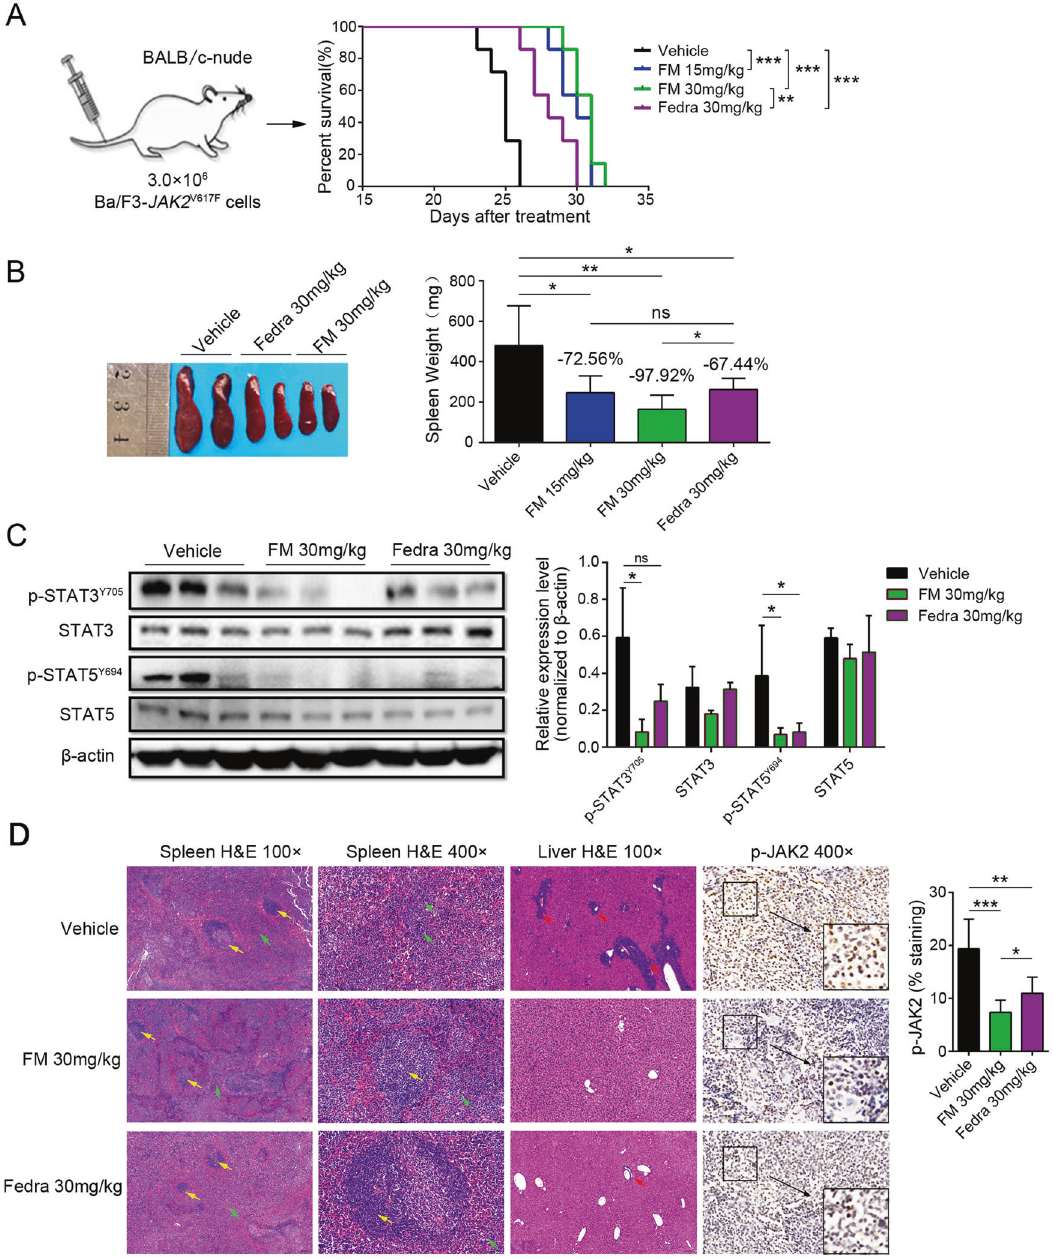
Fig. 3 Effective inhibition of JAK2 V617F -induced MPN mouse model in vivo by FM. BALB/c-nude mice received intravenous inoculation of 3.0 × 10 6 Ba/F3- JAK2 V617F -GFP cells and were administered with the vehicle, FM 15 and 30 mg/kg, and fedratinib 30 mg/kg bid. p.o. after 3 days, and the mice were executed after 22 days of treatment. A Kaplan – Meier analysis of survival between the vehicle-, FM- and fedratinib-treated groups was performed using the log-rank test ( n = 7). B Spleens were acquired and analyzed ( n = 6). C Western blot analysis of phosphorylated STAT3/5 and total STAT3/5 levels in spleens ( n = 3). D Representative histological sections of the spleen and liver sections and the extent of myelo-erythroid in fi ltration were stained with H&E, and the expression of p- JAK2 in the spleen was assayed via IHC staining. White pulp (yellow arrow), red pulp (green arrow), and tumor cell in fi ltration (red arrow) were marked. Images were obtained at ×100 and ×400 magni fi cation. The histogram on the right panel is the quantitative statistics of IHC staining results performed by Image-Pro Plus. Data are represented as mean ± SD, * p < 0.05, ** p < 0.01, *** p < 0.001 vs. vehicle, t histopathological analysis revealed that the tumor in fi ltration was in vitro fi ndings, FM decreased the p-STAT3 and p-STAT5 levels signi fi cantly reduced, and extramedullary hematopoiesis was after 22 days of treatment (Fig. 3C). Immunohistochemistry (IHC) improved in the FM therapy group. Unlike the myelo-erythroid analysis indicated that both FM and fedratinib signi fi cantly in fi ltration observed in spleens of vehicle-treated mice, FM inhibited the protein level of p-JAK2 in the spleen, whereas FM therapy restored normal splenic architecture (Fig. 3D). Overall, exhibited a stronger inhibitory effect than fedratinib (FM vs. the expansion of the erythroid progenitor characteristic of the fedratinib at 30 mg/kg, p = 0.0441) (Fig. 3D). Furthermore, the